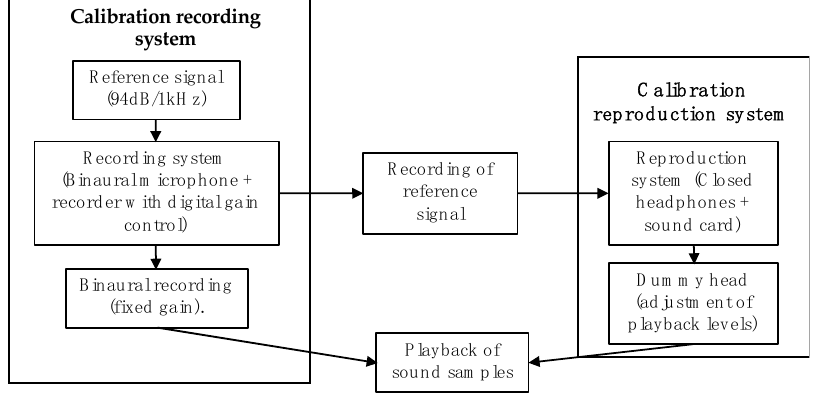
Figure 3. Calibration process diagram for the recording and reproduction of acoustic environments in laboratory test.